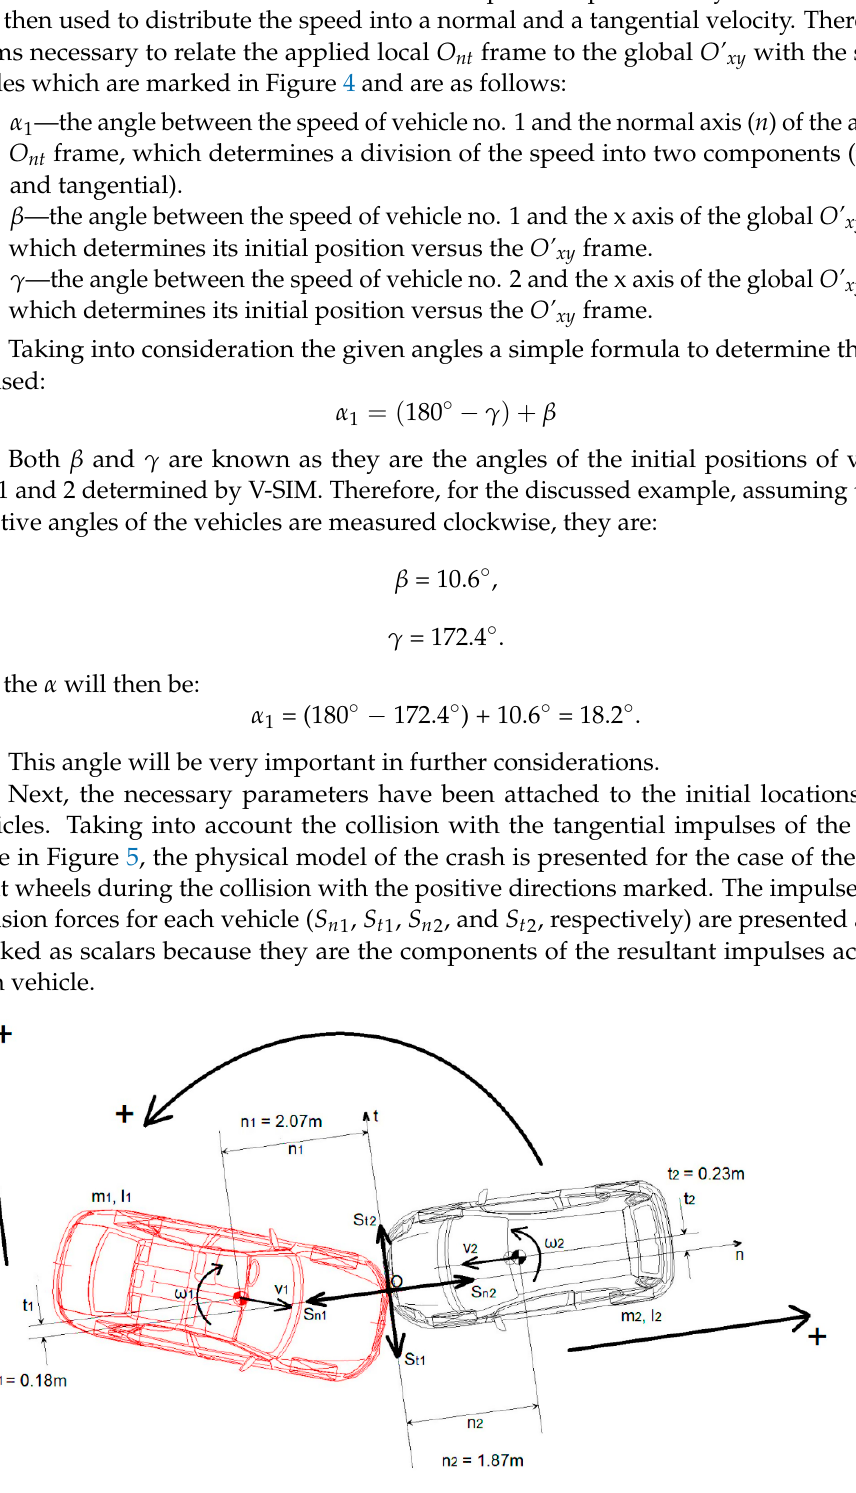
Figure 5. The mutual location of both vehicles at the beginning of the collision with the positive directions marked.